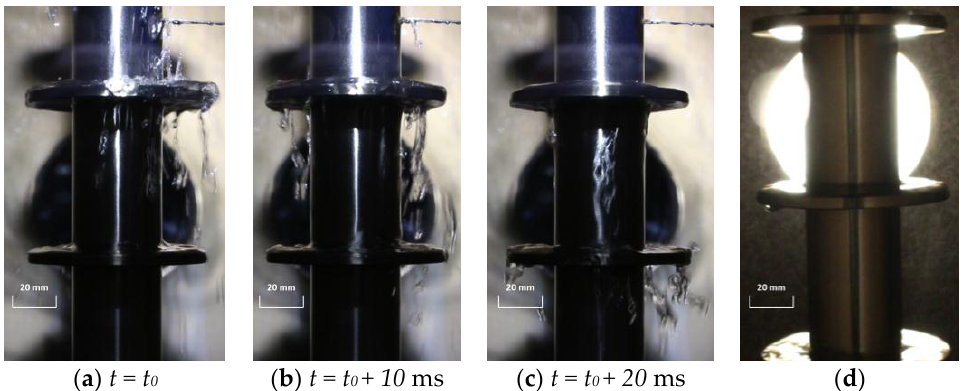
Figure 8. Visualization results of the liquid condensate on annular fins when air mass fraction is 0.447 at 4 bar. ( a – c ) Flooding of the condensate captured with a time interval of 10 ms; ( d ) Thick liquid film retained on the disk between flooding.